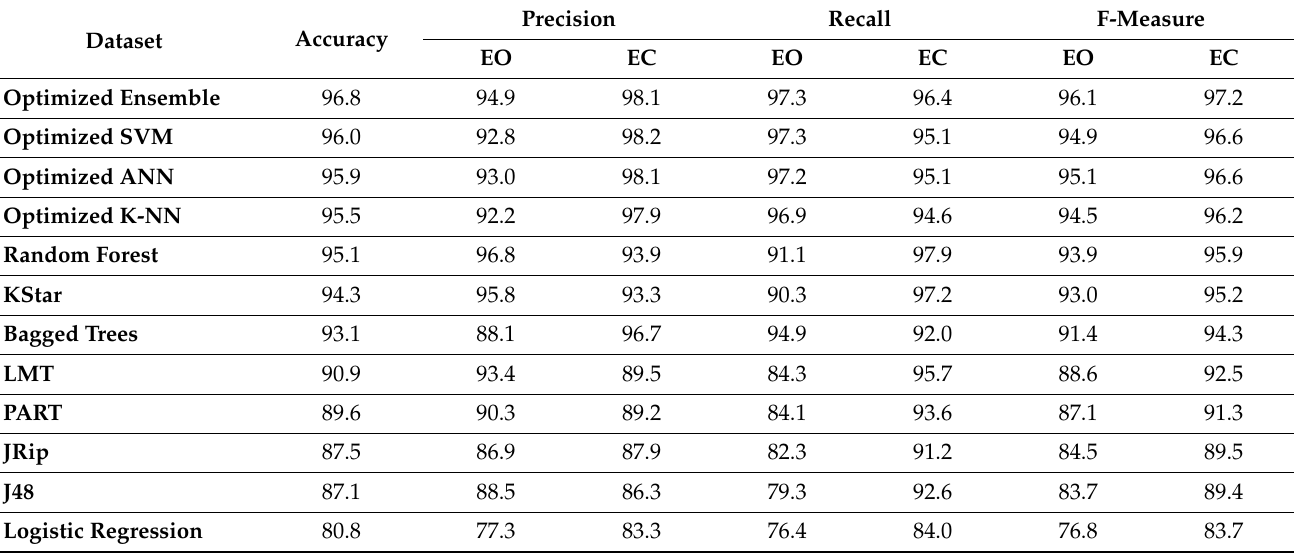
Table A3. The performance of the classifiers on Dataset CP40-M .